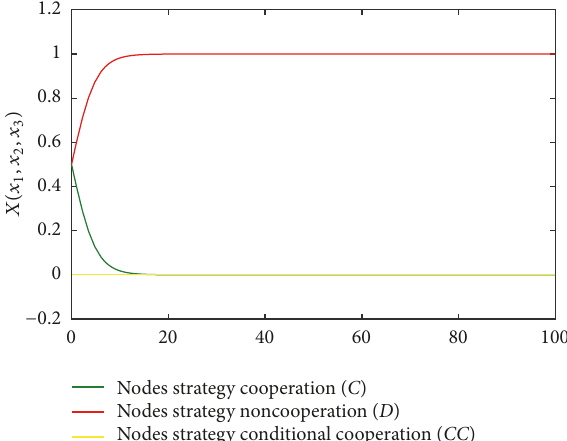
Figure 1: The state of population when 𝑥 = (0.5, 0.5, 0) .